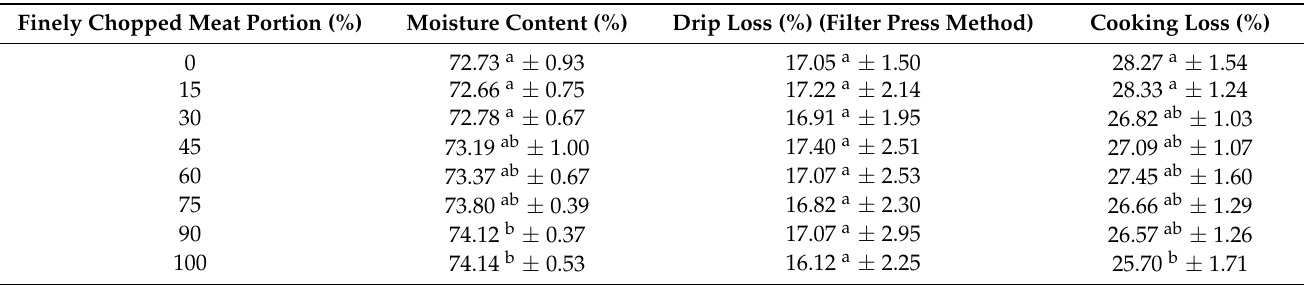
Table 1. Moisture content, drip loss by filter press method and cooking loss (mean ± standard deviation) of minced meat with finely chopped meat added ( n =